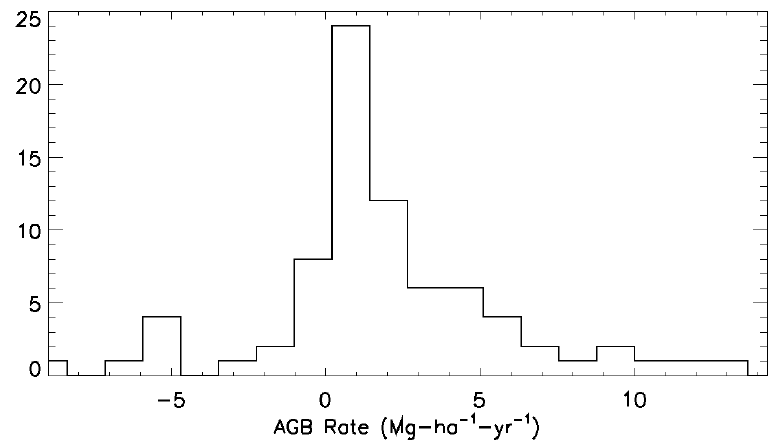
Figure 11. Histogram of the AGB rates of Figure 10 for the 78 plots in this study. The AGB-rates for AGB < 250 Mg-ha − 1 are on average positive, and become close to zero for AGB > 250 Mg-ha − 1 . Table 2 below summarizes secondary-, primary-, and all-forest average